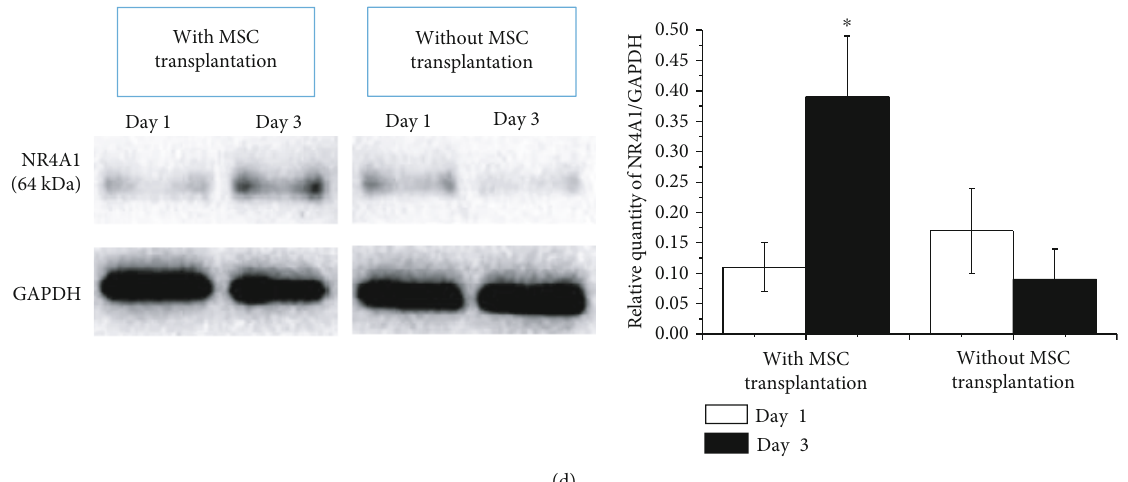
Figure 2: Conversion of Ly6C high to Ly6C low monocytes in AMI mice following transplantation with MSCs. (a) Ly6C low monocyte levels in the circulation of AMI C57BL/6 CX3CR1-/- and AMI C57BL/6 AMI mice day 3. (b) Circulating Ly6C low monocytes in AMI C57BL/6 CX3CR1-/- mice with or without MSC transplantation on day 1 and day 3. (c) Levels of Ly6C low monocytes in fi ltrated in the AMI hearts of C57BL/6 CX3CR1-/- mice with or without MSC transplantation on day 1and day 3. (d) Levels of NR4A1 in AMI hearts of C57BL/6 CX3CR1-/- mice were then tested. ∗ p < 0 : 05 at day 3 vs. the fi rst day. Abbreviations: FITC: fl uorescein isothiocyanate; MSCs: mesenchymal stem cells;